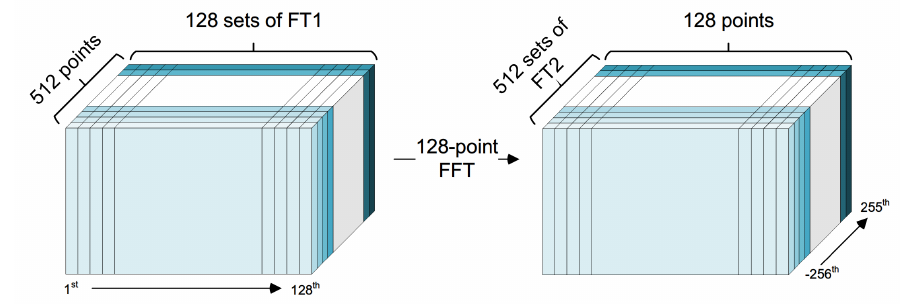
Figure 5. The calculation process of FT2